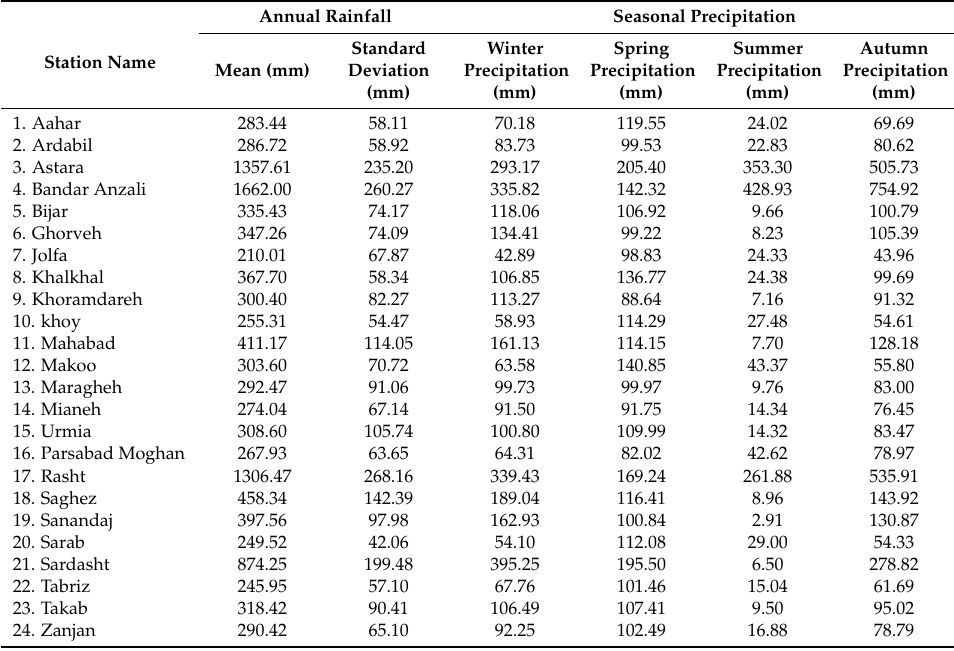
Table 1. Mean and standard deviation of annual rainfall and seasonal rainfall at each